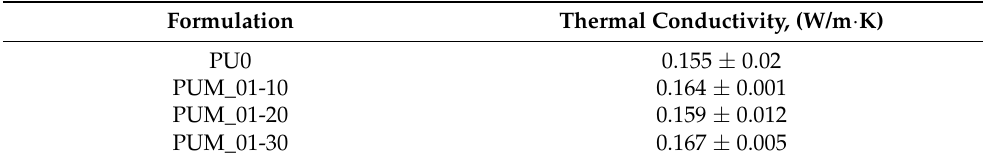
Table 5. Effect of fiber percentage on reinforced Polyurethane foam thermal